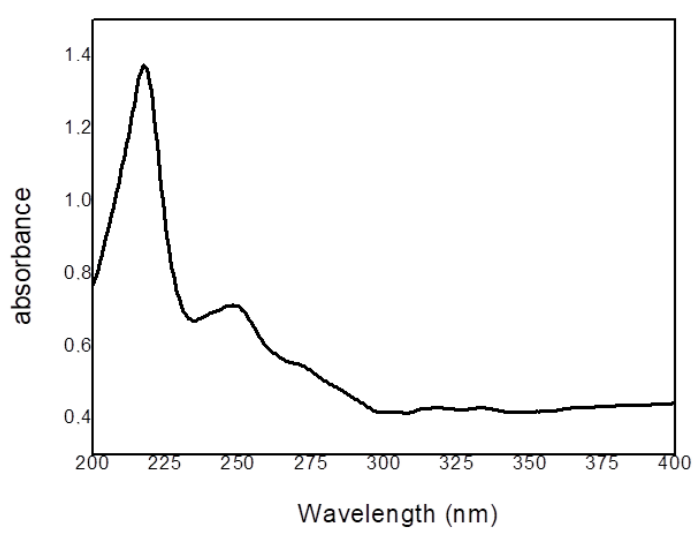
Figure 3. Ultraviolet–visible (UV-Vis) diffuse reflectance spectroscopy for 10% Mo/CNT catalyst. The H 2 -TPR (a), O 2 -TPO (b), and NH 3 -TPD (c) profiles of the 10% Mo/CNT catalyst